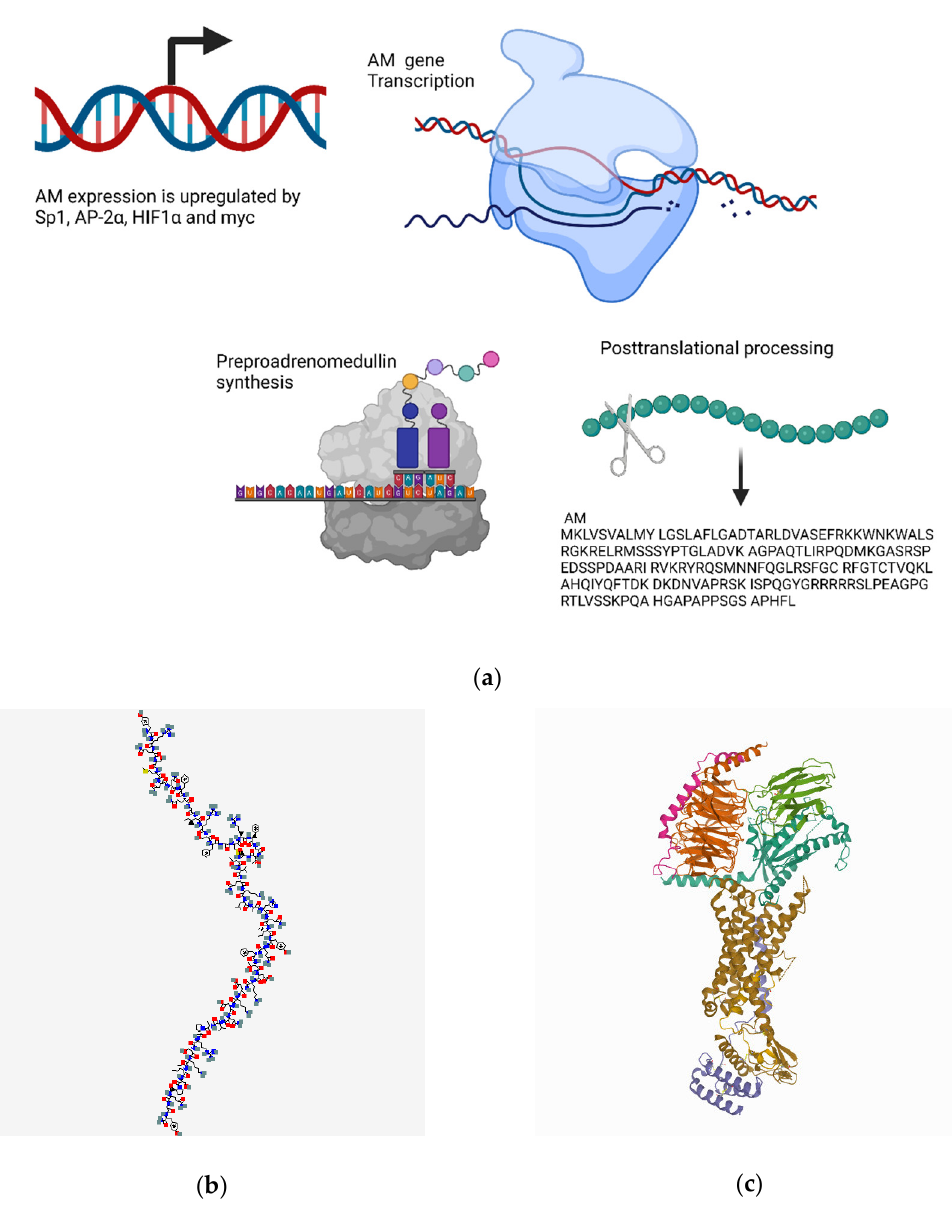
Figure 4. Neuropeptide AM and receptors: ( a ) transcription and synthesis of AM (created with BioRender.com accessed on 22 October 2021); ( b ) 2D structure image of AM (https://pubchem.ncbi.nlm.nih.gov/compound/56841671#section=2D-Structure, accessed on 22 October 2021); ( c ) CryoEM structure of the active adrenomedullin 1 receptor G protein complex with adrenomedullin peptide. Image from the RCSB PDB (rcsb.org) of PDB ID 6UUN [85].